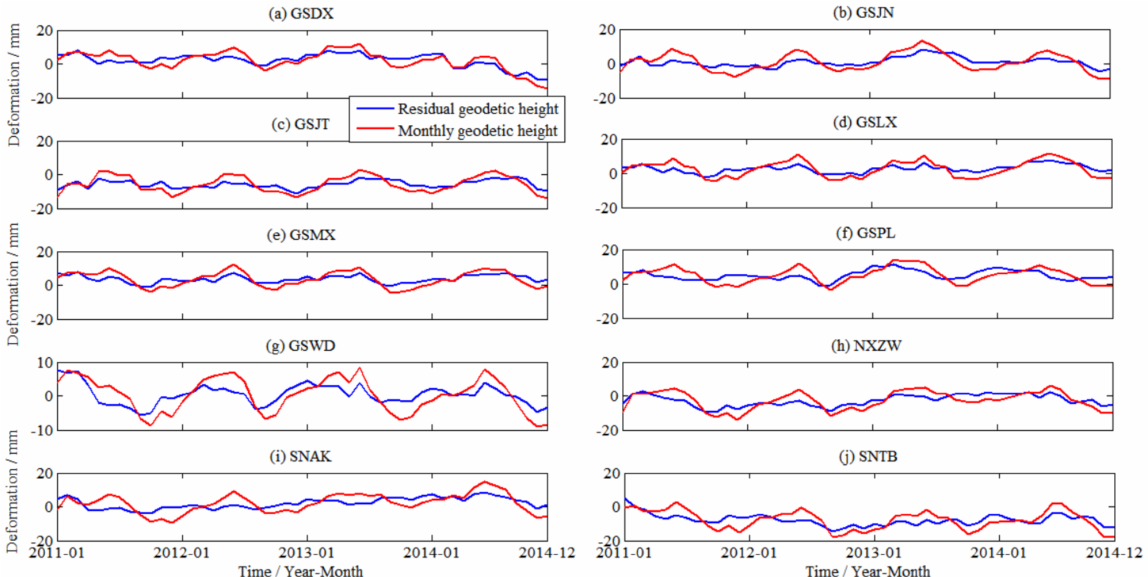
Figure 5. The monthly variation in geodetic height at ten CORS stations and the residual geodetic height change after deducting the total load